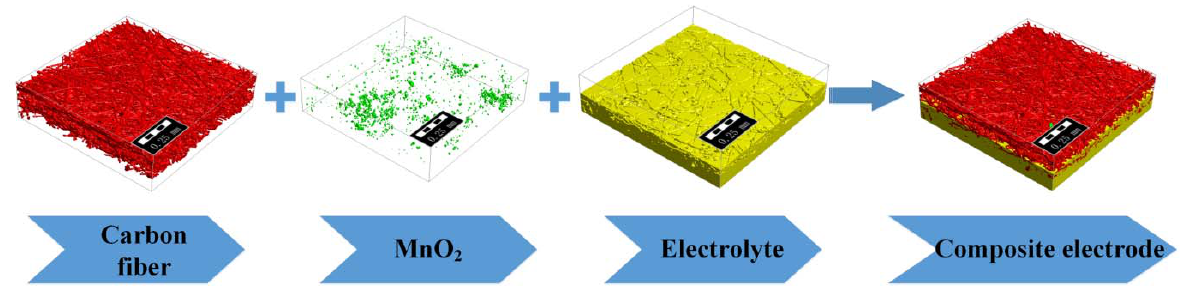
Figure 3. Construction of composite electrode filled with organic electrolytes.